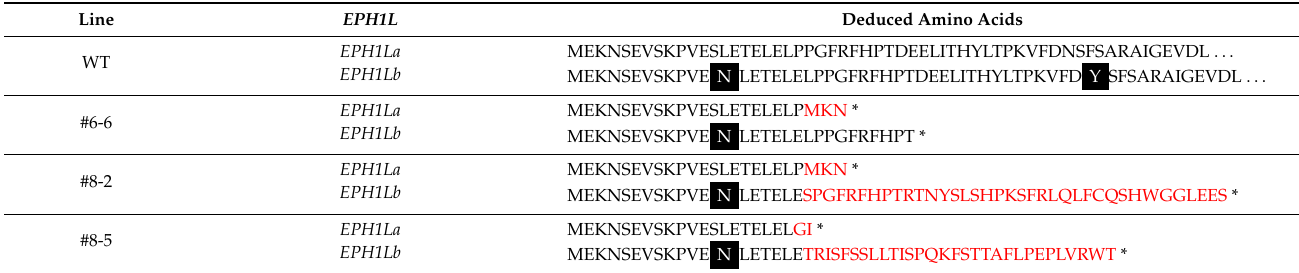
Table 2. Amino acids sequences of WT and mutant forms of